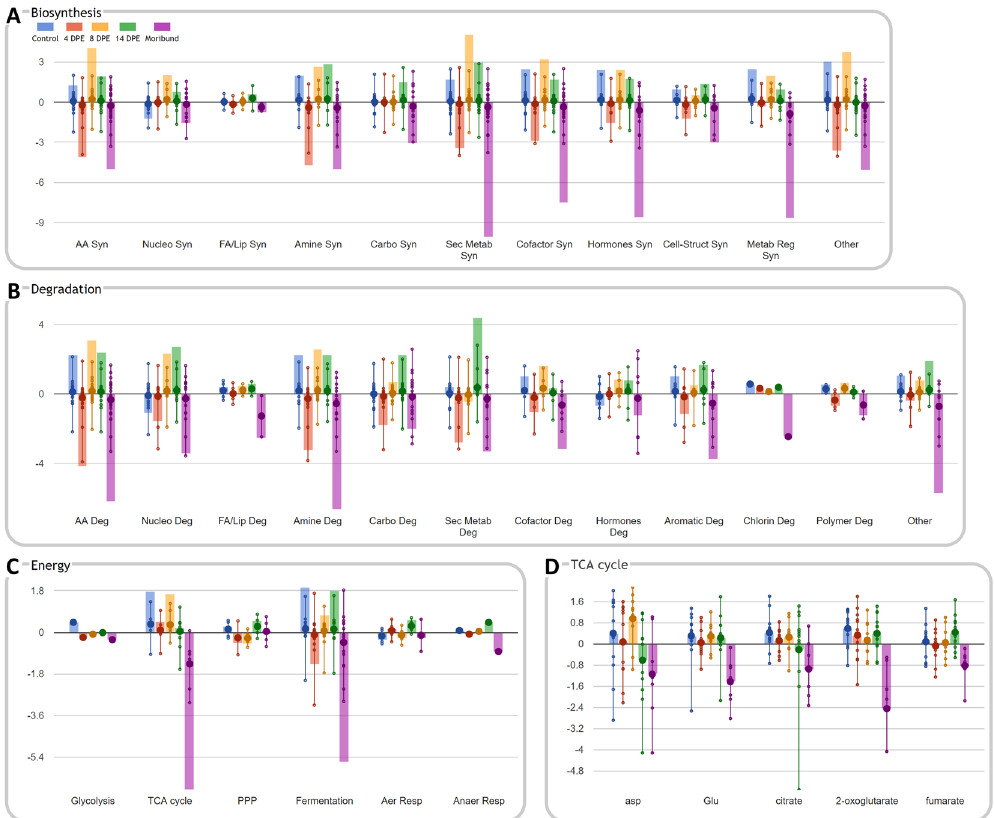
Figure 3. Relative accumulation levels of skin metabolites (from frogs grouped by sampling period) associated with key cellular systems ( A ) Biosynthesis, ( B ) Degradation, ( C ) Energy, and ( D ) relative accumulation data for tricarboxylic acid cycle subsystem intermediates. Large dots represent mean data values for relevant metabolites involved in various subsystems, and small dots represent individual metabolite values. Vertical axis represents normalized relative metabolite accumulation values. Solid colour bars provide the cumulative sum of data values for relevant metabolites, and are more pronounced where many metabolites make a consistent contribution to change within a